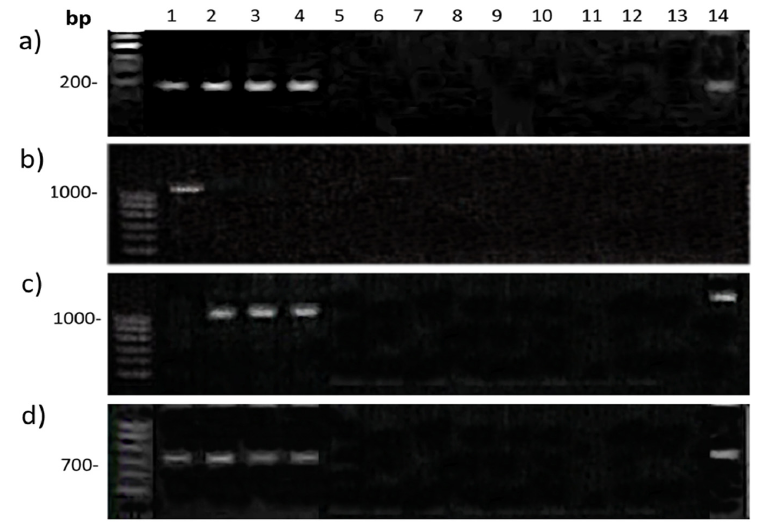
Figure 6. PCR amplification with primers: Qex10f/Qex10r ( a ); QTaF/QTaR ( b ); QTsF/QTsR ( c ); and Qpromf/Qpromr ( d ). Samples: 1— T. aestivum Chinese Spring; 2–4—triticale; 5–7—hybrid Line 808/1; 8–10—hybrid Line 844/4; 11–13—hybrid Line 857; and 14— S. cereale .